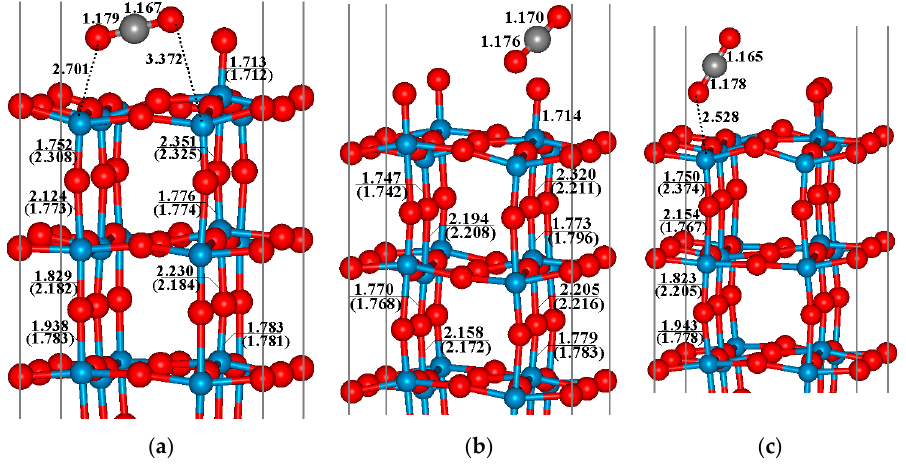
Figure 4. Oxidation product for CO reacting with ( a ) the O t atom on perfect WO 3 (001) surface; ( b ) the O atom belongs to the O 2 − species and ( c ) the O t atom on defective WO 3 (001) surface modified by the pre-adsorbed O 2 molecule.